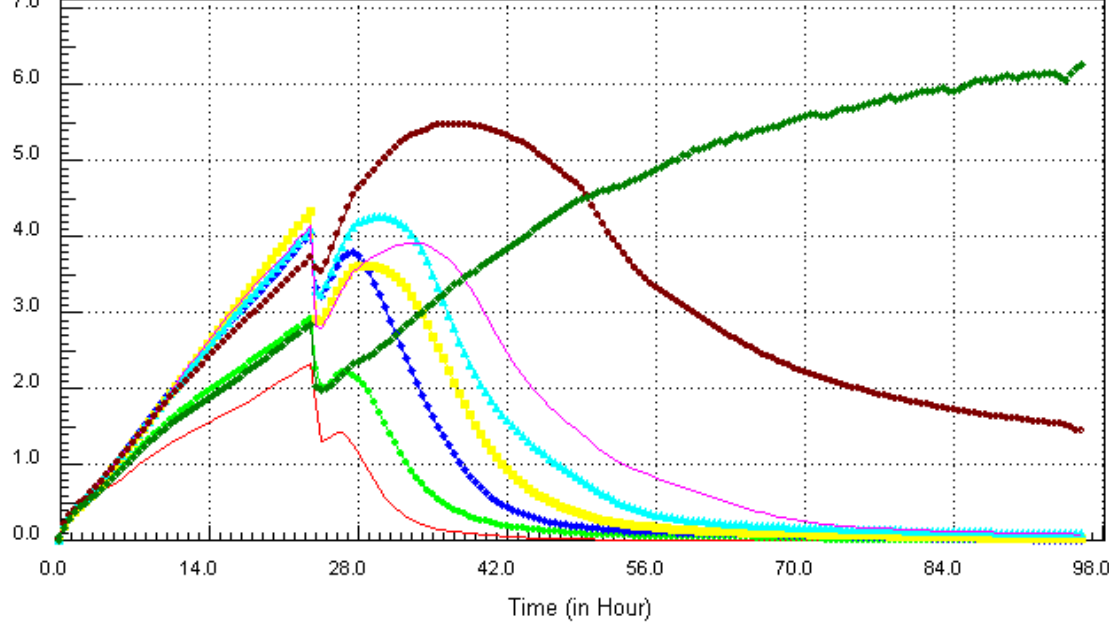
Figure 8. Kinetics of cytotoxic responses for mercury in LBSO-treated MCF7 cells as described in Figure 6